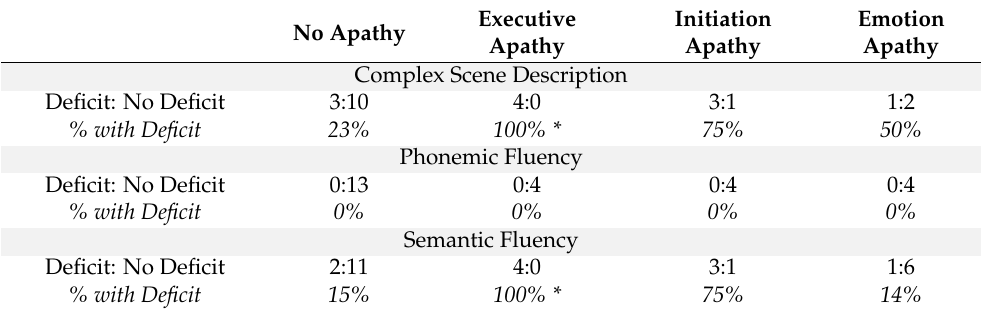
Table 6. Language generation deficit and apathy subtype: Number of impaired PD participants.